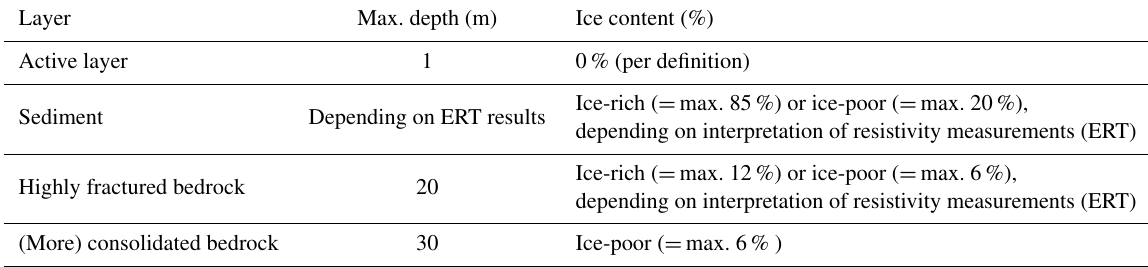
Table 2. General assumptions of layers used in the conceptual soil stratigraphy models for the ground ice content calculations for Site D, where (i) no 4PM results exist, (ii) ground truthing data are absent, and/or (iii) the investigation depth from the geophysical methods is not